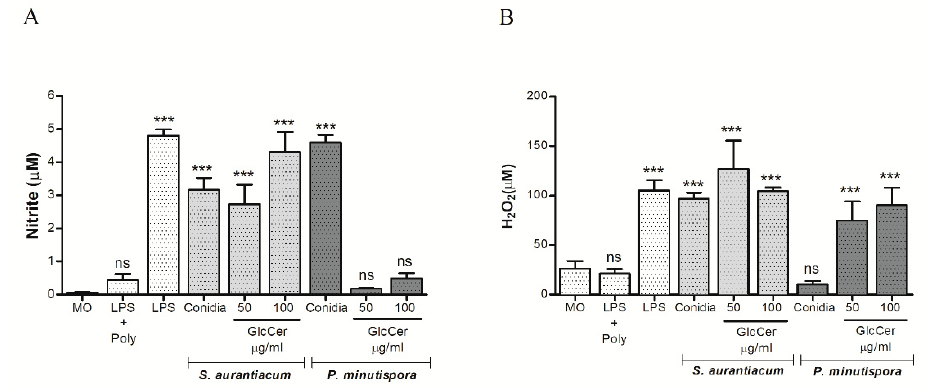
Figure 6. Activation of the oxidative burst in peritoneal macrophages. Macrophages (2.5 × 10 5 ) were incubated at 37 ◦ C for 2 h in the presence of S. aurantiacum and P. minutispora conidia, as well as 50 and 100 mg / mL of purified GlcCer (Glucosylceramide) from both fungi in order to quantify nitrite ( A ) and H 2 O 2 ( B ). As positive controls, LPS (lipopolysaccharide) (10 ng / well) was used. Data are the mean of duplicate samples from four independent experiments. p < 0.001; + Poly, polymyxin added. *** p < 0.001.